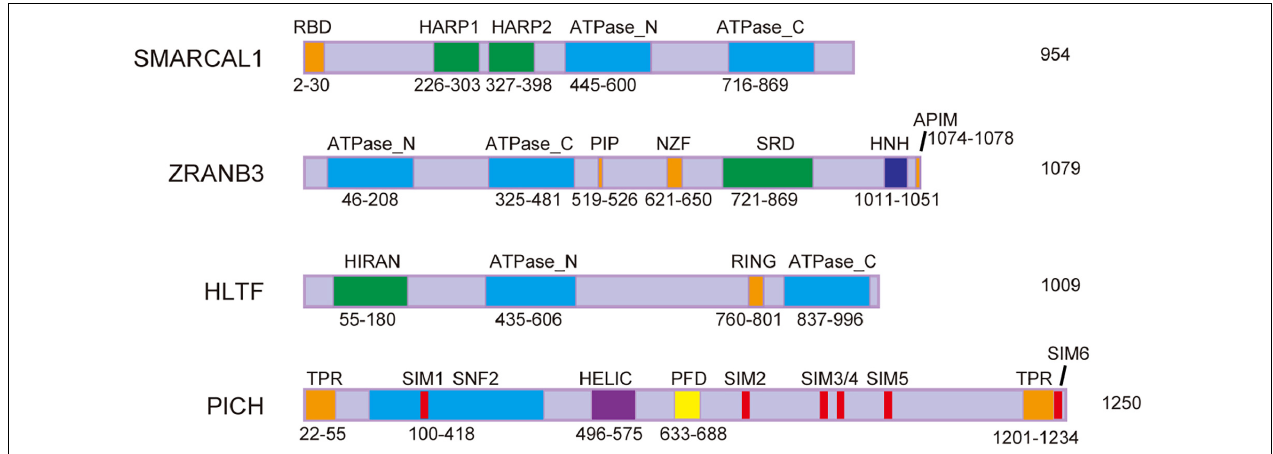
FIGURE 1 | Schematic representation of protein domains of SMARCAL1, ZRANB3, HLTF, and PICH. RBD, RPA-binding domain; HARP, HepA-related protein; PIP, PCNA-interacting protein box; NZF, Npl4 zinc-finger; SRD, substrate recognition domain; HNH, His-Asn-His protein; APIM, AlkB homolog 2 PCNA interacting motif; HIRAN, HIP116 and RAD5 N -terminal; RING, really interesting new gene; TPR, tetratricopeptide repeat; SIM, SUMO-interacting motif; SNF2, sucrose non-fermenting 2; HELIC, helicase superfamily c -terminal domain; and PFD, PICH family